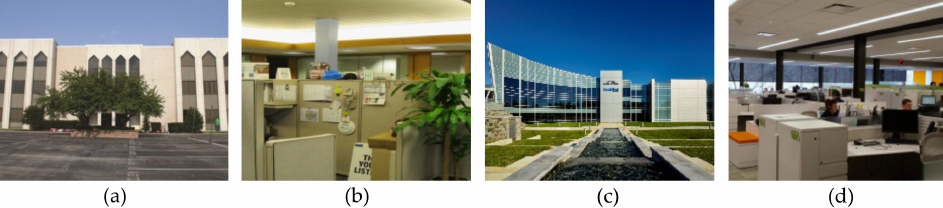
Figure 1. ( a ) Traditional building complex. ( b ) Typical workstation of traditional building. ( c )